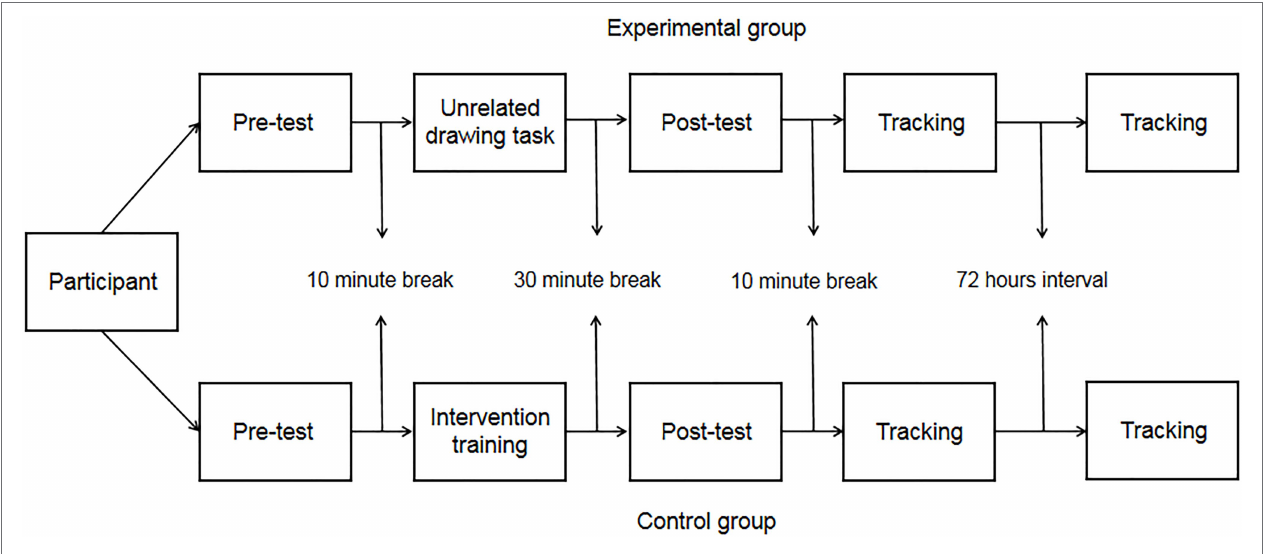
FIGURE 4 | Experimental flow chart of Experiment 2a.